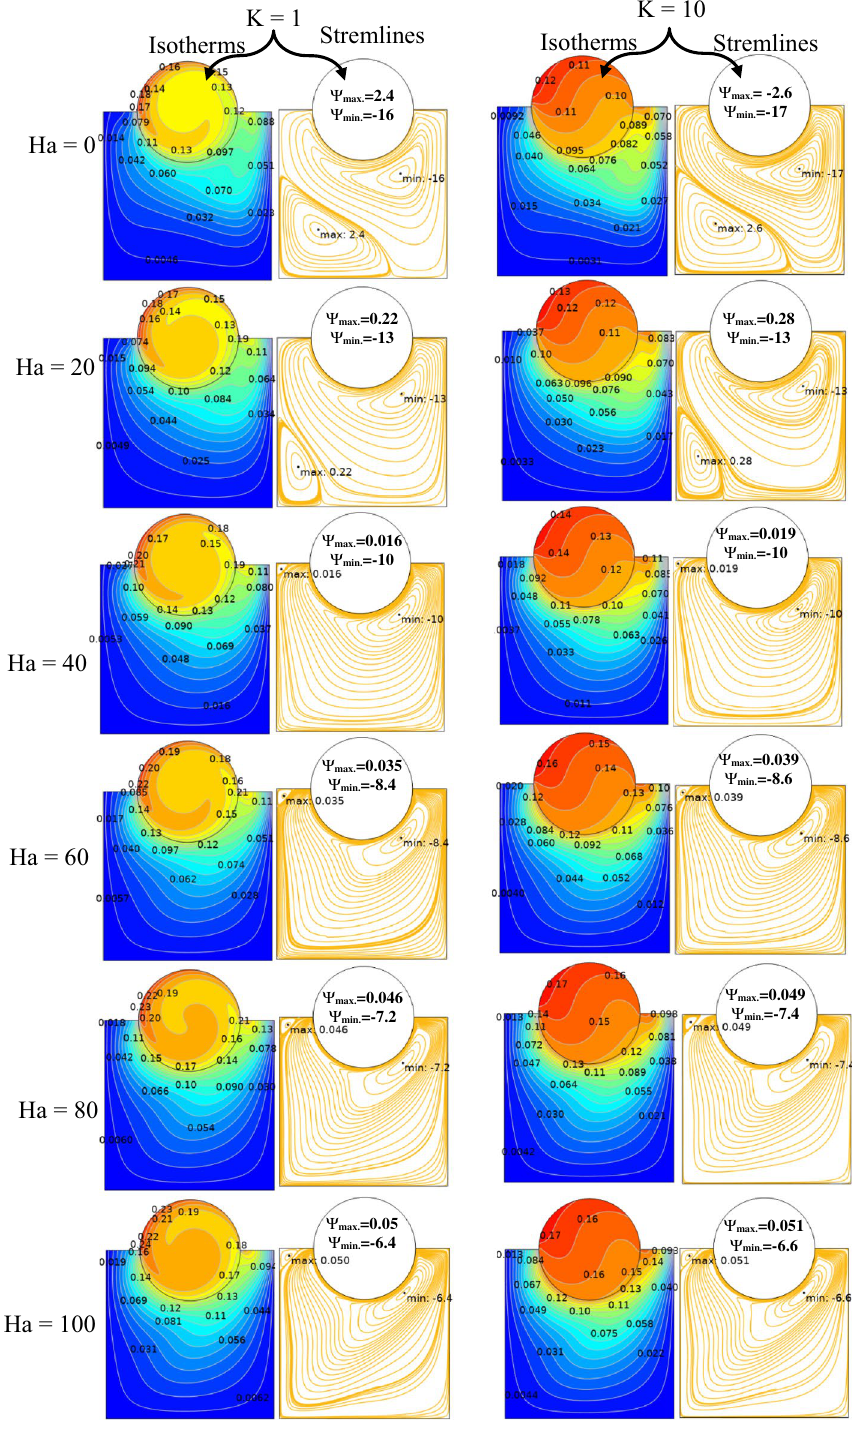
Figure 7. Isotherms and streamlines contours for different Hartmann numbers and thermal conductivity ratios at Ra = 10 6 , λ = 0.52, and = ϕ